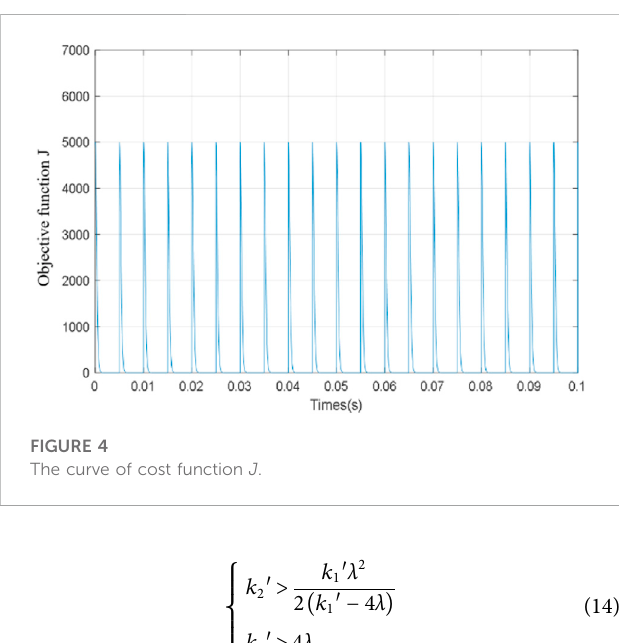
FIGURE 4 The curve of cost function J .